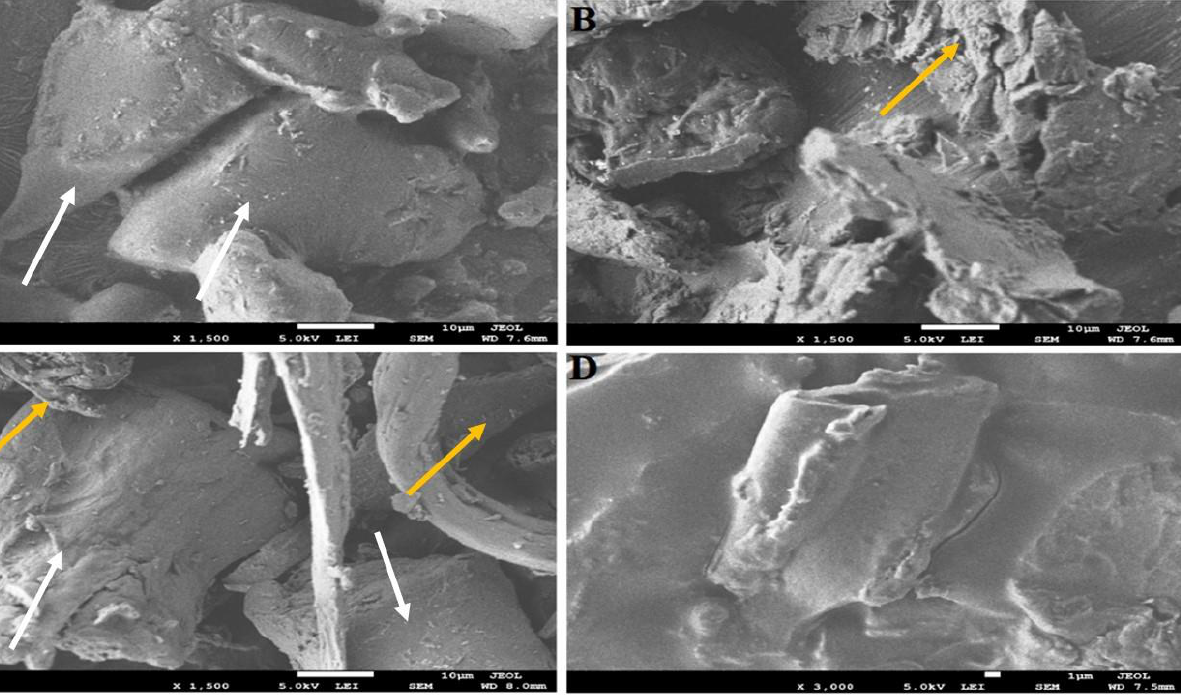
Figure 3. SEM characterization of ( A ) ginkgo extract, ( B ) sodium alginate, ( C ) dry physical mixture, and ( D ) NG. The arrows are indicating the morphology changes between the groups.